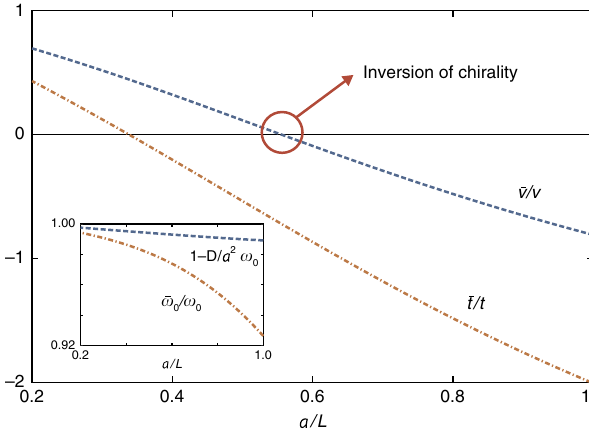
j / j e i φ q þ τ j on q 0 τ Fig. 4 Tunable parameters in the effective Hamiltonian. Dependence of the parameters in the effective polariton Hamiltonian (Eq. (9)) on the inverse cavity height. The blue dashed line shows the variation of the group velocity v which changes sign at the critical cavity height L c , leading to the inversion of chirality. The orange dot-dashed line shows the variation of the trigonal warping parameter t which becomes dominant close to criticality. These parameters have been normalized to v = 3 Ω a /2 and t = 3 Ω a 2 /8 which are the group velocity and trigonal warping parameters, respectively, in the absence of image dipoles and light – matter interactions. The orange dot- dashed line in the inset shows the variation of the CDP frequency ω 0 , while the blue dashed line in the inset shows the variation of the wavevector- ¼ 2 : 5 ω Ω = 0.01 ω dependent diagonal term D . Plots obtained with ω ph 0 0 and K 0